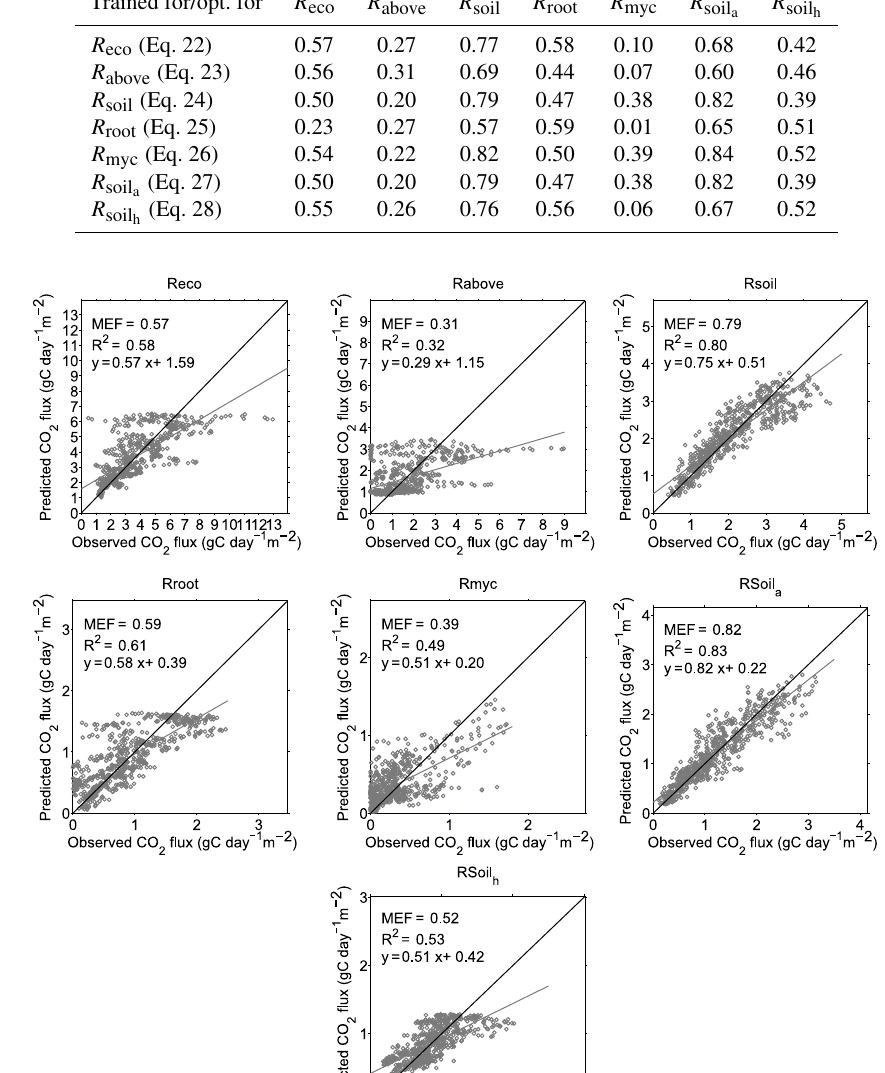
, and R soil , and back-transformed with a smear term bias correction. a h